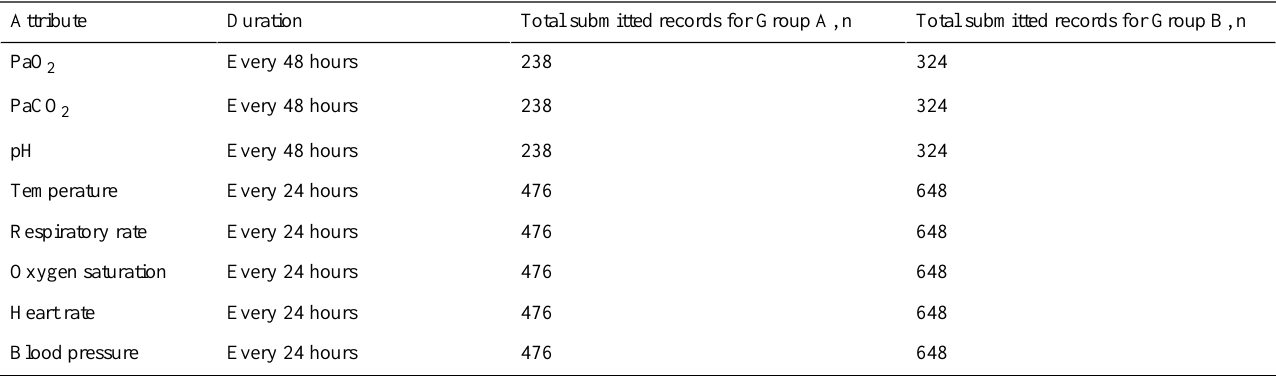
Table 2. Parameters of the submitted